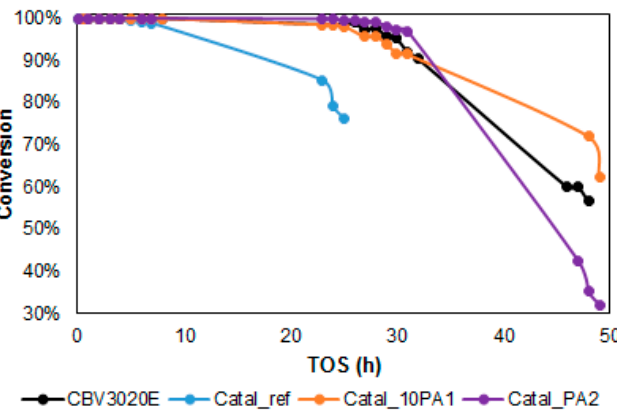
ff erent catalysts’ Figure 4. Profiles of the different catalysts’ lifetimes. Figure 4. Profiles of the di